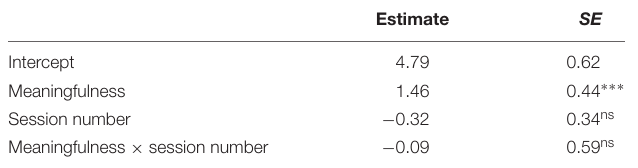
TABLE 4 | Model testing for the effect of meaningfulness on ANL.